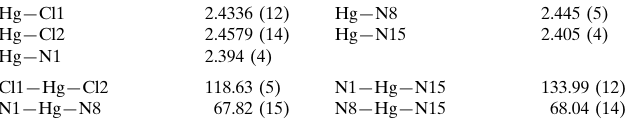
Selected geometric parameters (A˚ , (cid:1)